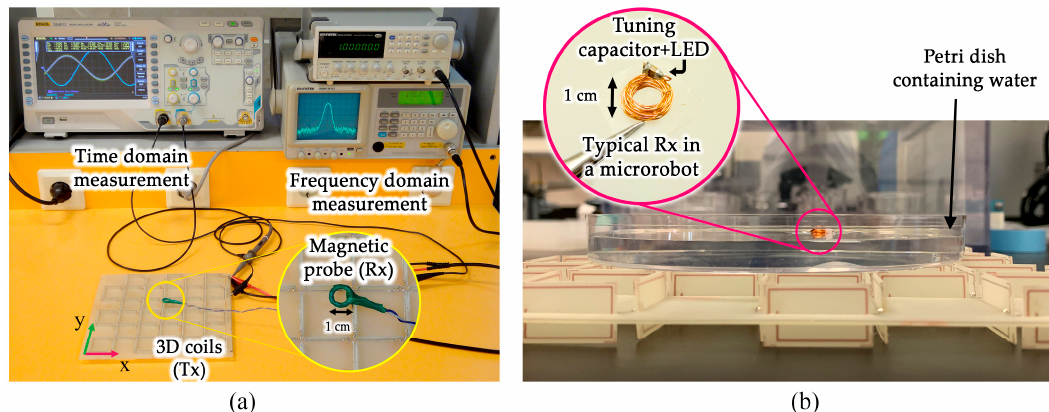
Figure 6. ( a ) The setup for measuring spatial patterns of the magnetic near-field at various distances from the transmitter (Tx) coil (gridded spacers not shown) at 1000 kHz. The magnetic probe had a similar structure to the microrobot’s power receiver coil. ( b ) The typical placement of a microrobot’s receiver (Rx) coil swimming on water. It is supplied by the single-sided power transmitter.